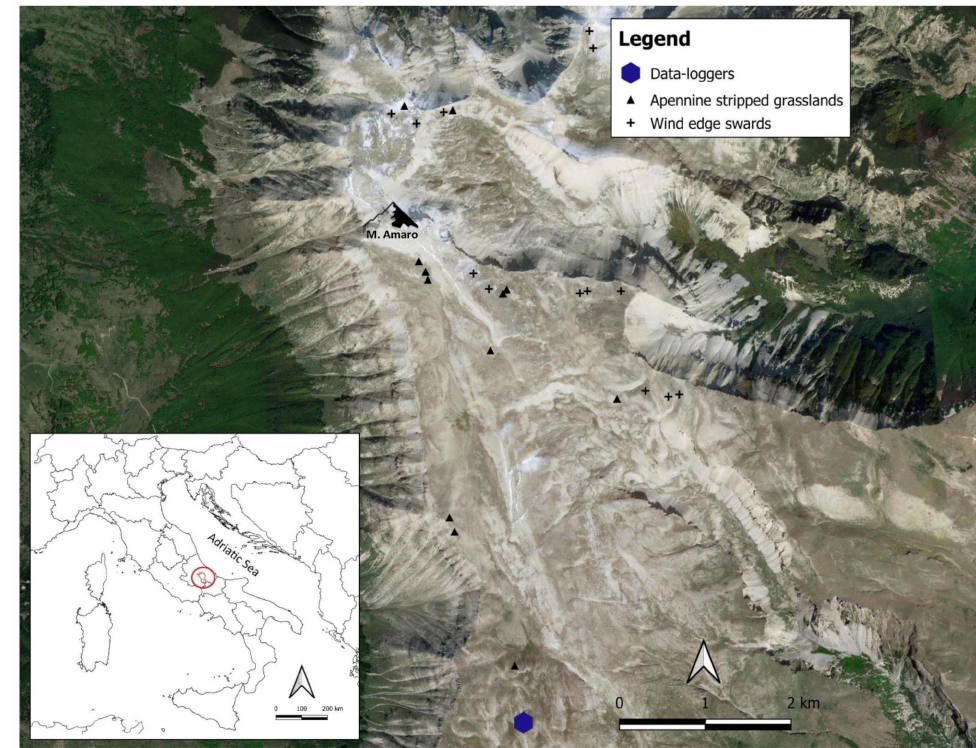
Figure 1. Study area (Maiella National Park) along with the distribution of vegetation plots on Apennine stripped grasslands (EUNIS code E4.436) and wind edge swards (EUNIS code E4.42) and of the GLORIA data-loggers measuring soil temperatures on Mt. Femmina